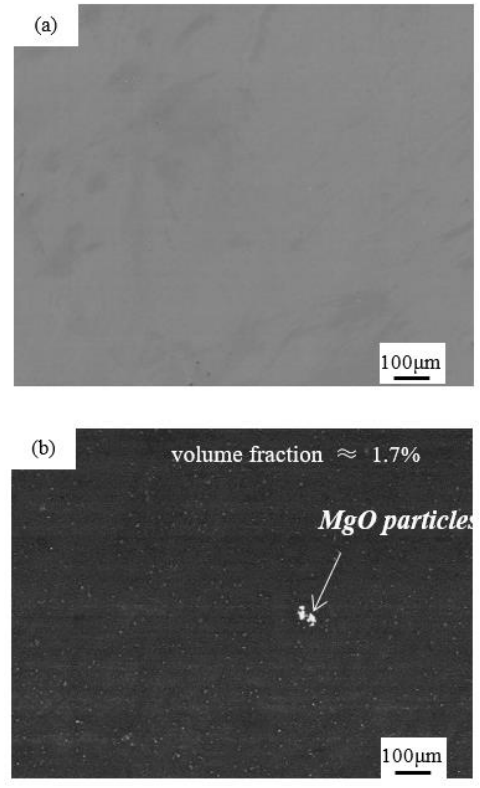
Figure 1. SEM micrographs of the MgO/Mg composites: ( a ) pure Mg; ( b ) oxidation for 2 min.